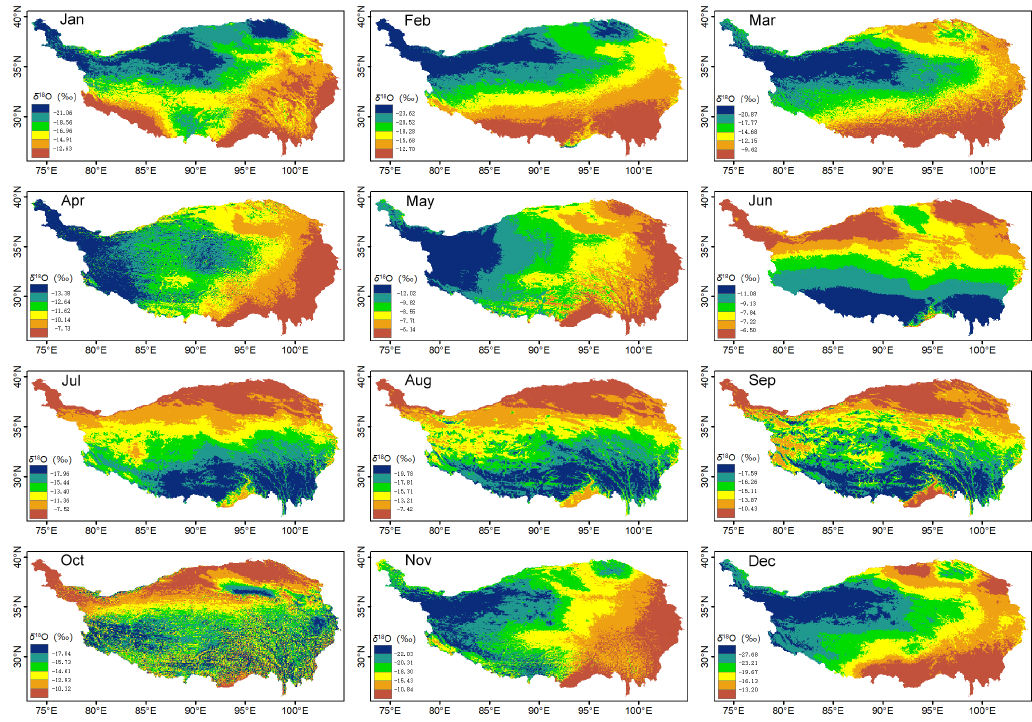
Figure 6. Monthly isoscape of stable oxygen isotopes in precipitation across the QTP.